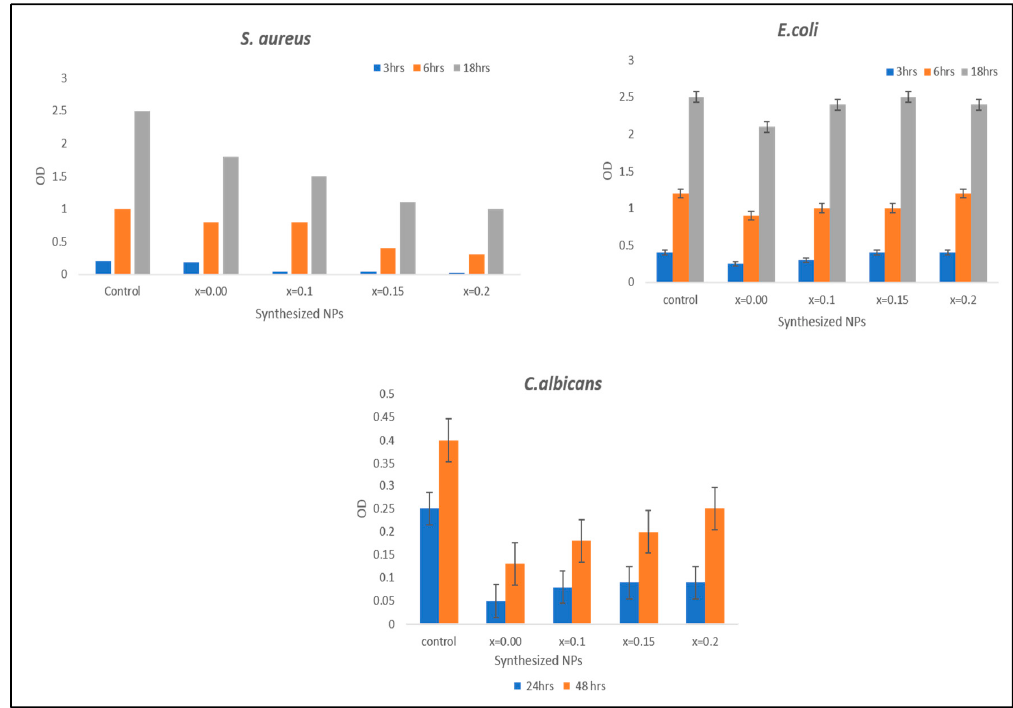
Figure 4. Growth pattern of microbes treated with 1 mg/mL of CoNd x Fe 2 − x O 4 (0.0 ≤ x ≤ 0.2) NPs at different time intervals, control; untreated cells.